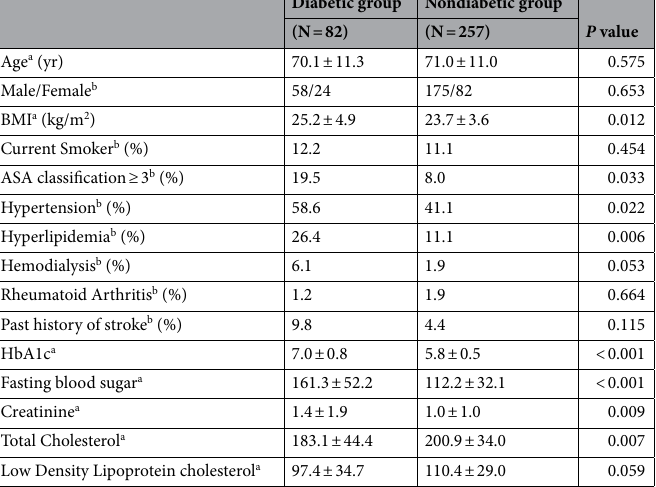
Table 1. Demographic and patient characteristics. BMI body mass index, ASA American Society of Anesthesiologists. a The values are given as the mean and the standard deviation. b The values are given as the percentage in each